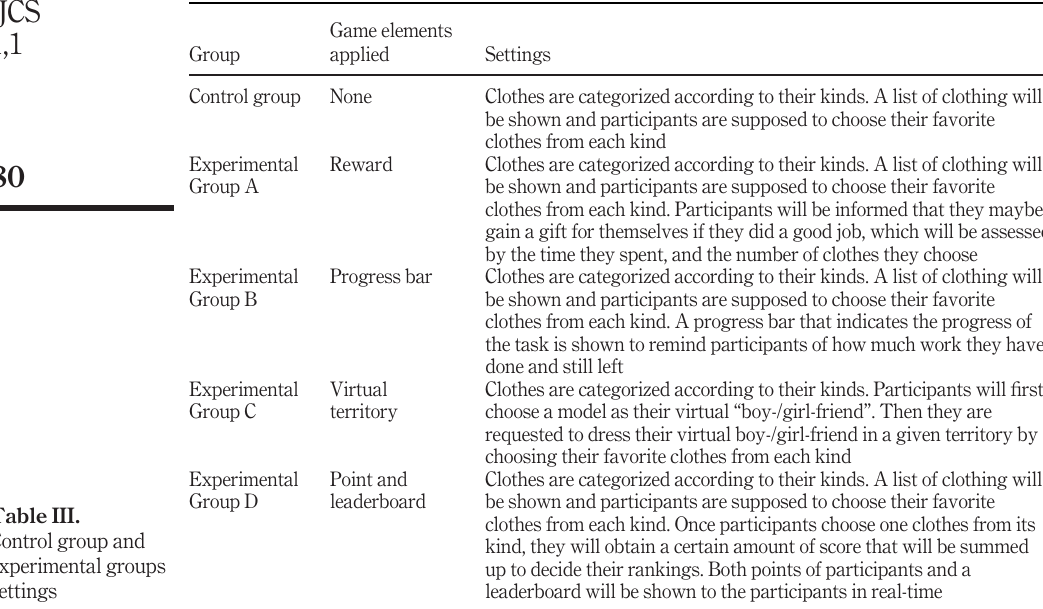
constructs – intrinsic motivation, two kinds of extrinsic motivation and two kinds of internalized intrinsic motivation – will be adapted from the Work Preference Inventory (Amabile et al. , 1994), which is used to assess intrinsic and extrinsic motivation. Two different choice sizes of the kinds of clothes will be taken as the measure of task complexity.